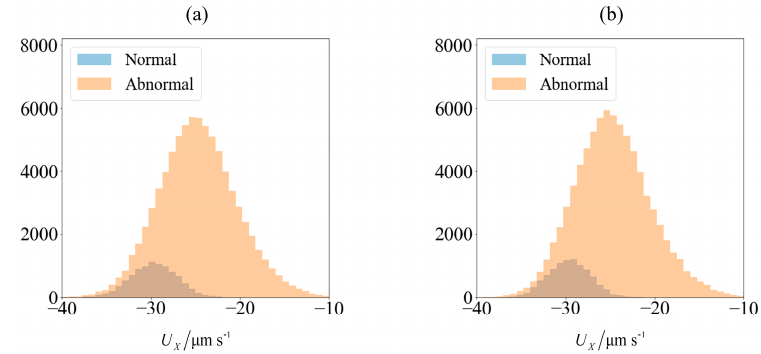
Figure 3. Velocity of spermatozoa in the test set of 90,000 samples ( a ) computed using slender body theory (SBT) computation and ( b ) obtained from predictions made using an ensemble of supervised learning trained on 10,000 samples. The blue and orange region represents the number of morphologically normal and abnormal cells, respectively. The sperm cells are not subjected to any applied field ( C 0 = 0).